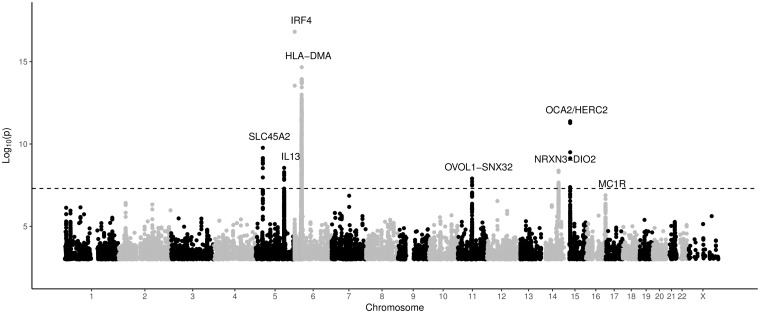
Manhattan plot of single-nucleotide polymorphisms in the rosacea GWAS group. The Manhattan plot depicts the distribution of association test results versus genomic position, with chromosomes 1 to 22, and X arranged along the X axis. The Y axis represents –log10 (P values). The P value threshold for declaring statistical significance at the GWAS level, P = 5 × 10−8, is indicated by the gray line. Loci with P < 5 × 10−8 are labeled with the name of the nearest gene. The MC1R gene association is annotated on the plot as well.